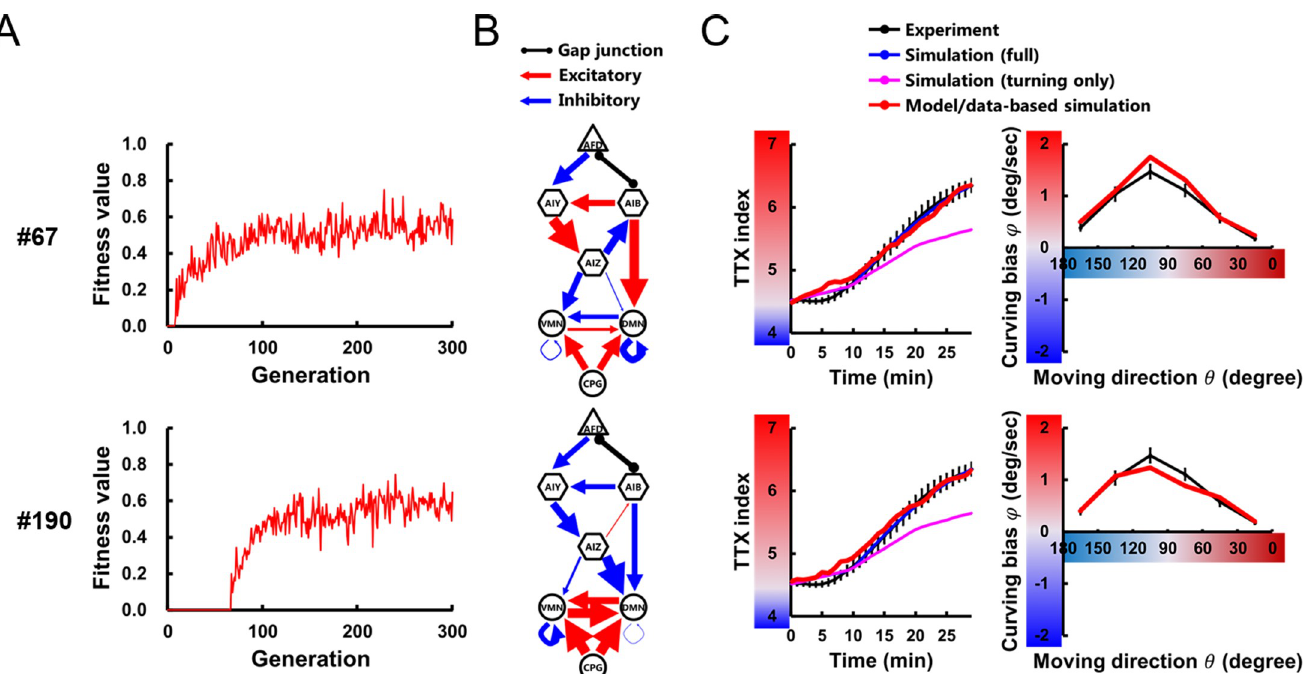
Fig 3. Neuroanatomical models reproduce thermotactic behavior. Through 200 evolutionary searches with 300 generations, 8 independent parameter sets that have fitness scores of at least 0.6 (A) were obtained ( S1 Fig ). Individual parameter sets were assigned numbers (#) from 1 to 200. For 2 of 8 models, the circuit diagram (B) , the time course of TTX index, and the profile of curving bias (C) are plotted. In the circuit diagrams, thickness of each connection is represented proportionally to its connection weight ( S1 Table ).